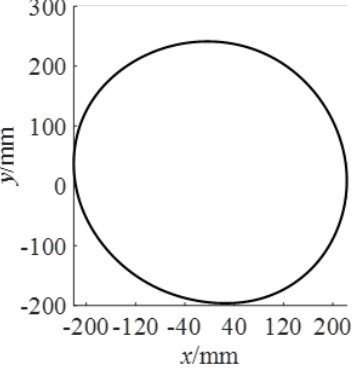
Figure 13. Motion characteristics before optimization.